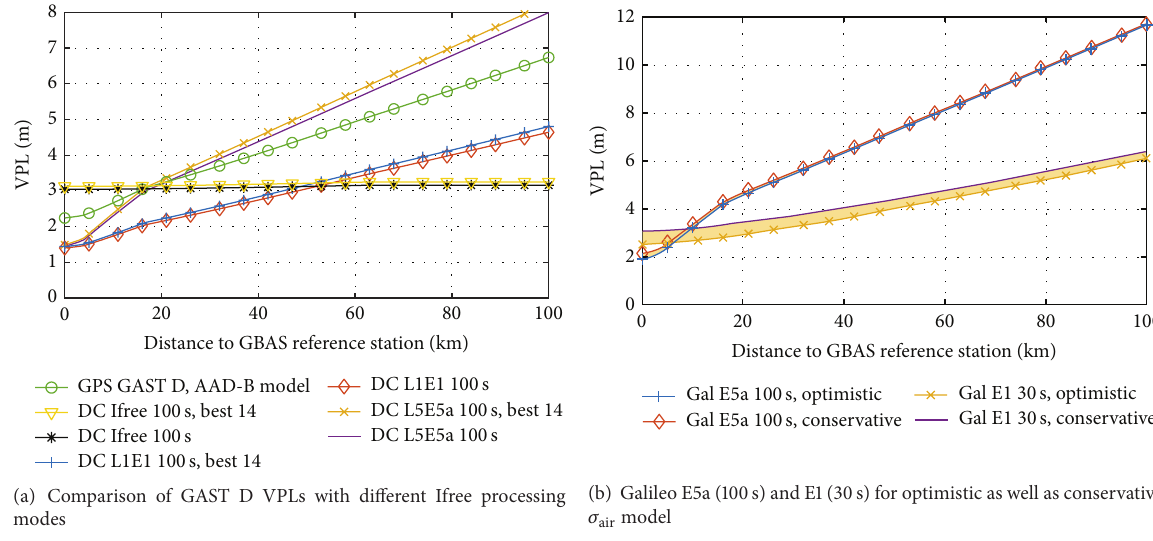
Figure 15: Comparisons of H0 VPL over distance for sets of different processing